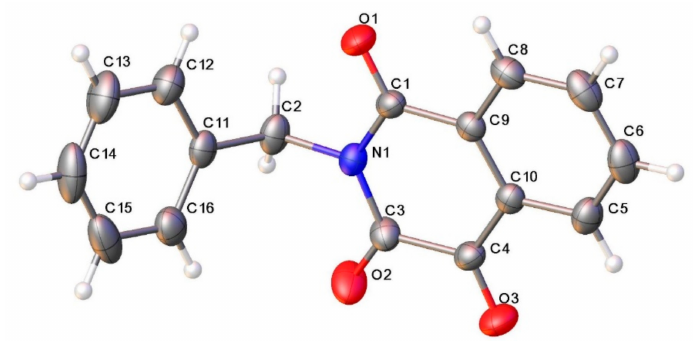
Figure 2. ORTEP drawing and atom numbering scheme of compound 3a . Hydrogen atoms have been omitted for clarity. Ellipsoids are drawn at 30% probability level. CCDC 1915668 contains the supplementary crystallographic data for this paper. These data can be obtained free of charge via http: // www.ccdc.cam.ac.uk / conts / retrieving.html (or from the CCDC, Cambridge, UK).